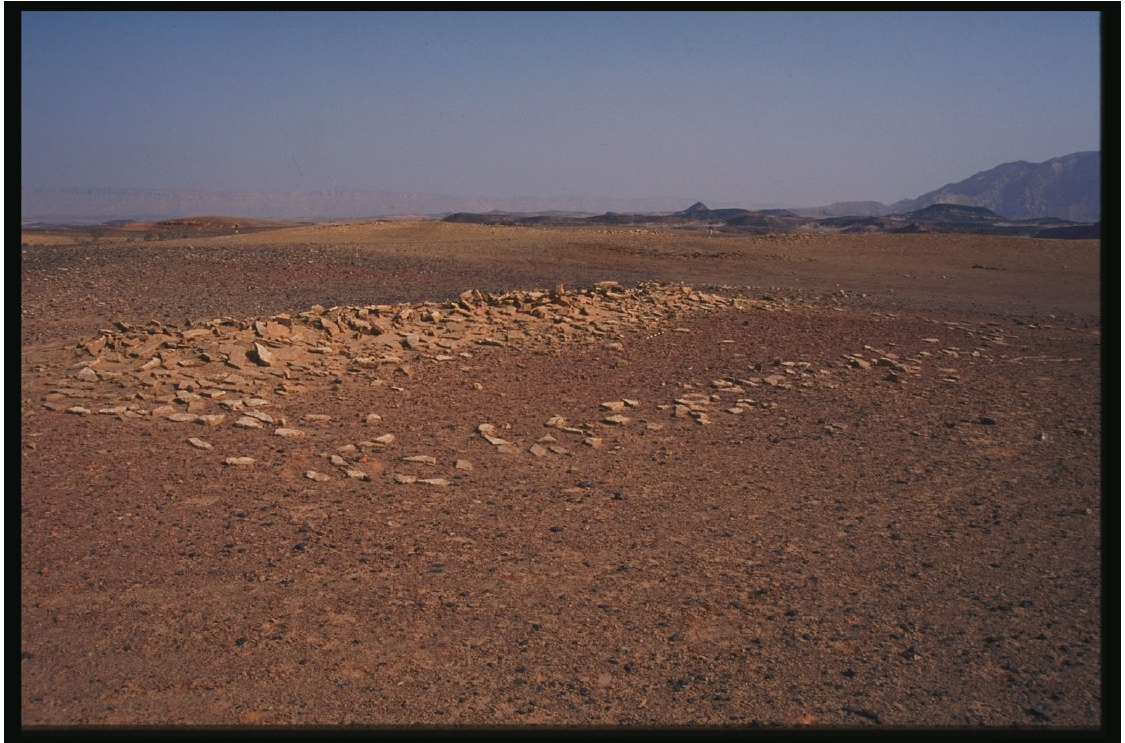
Figure 6 Ramat Saharonim solstice shrine, rectangular structure, looking roughly N. (Photo by S.